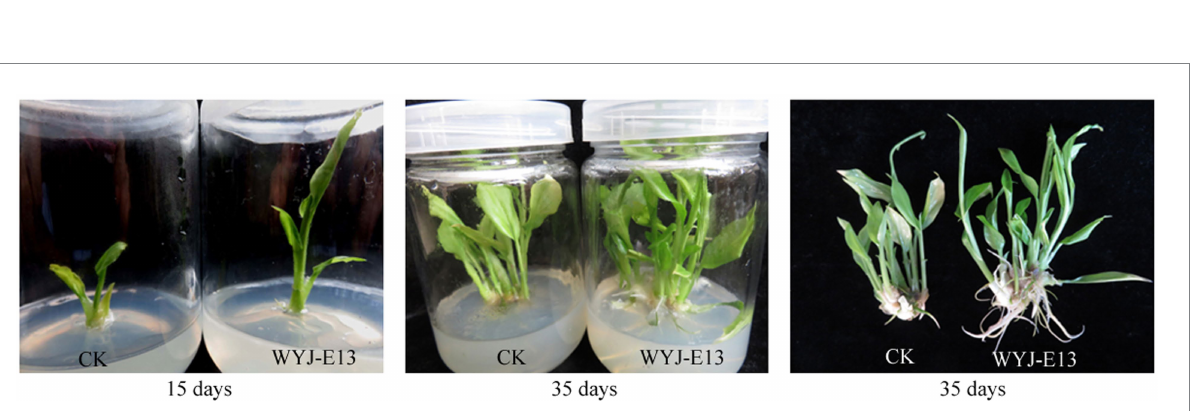
FIGURE 2 Plant growth promotion assay of Rhizobium sp. WYJ-E13 on the Curcuma wenyujin after 15 days and 35 days of